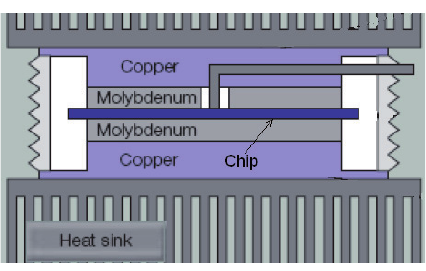
Fig. 5. Pressure Pack assembling stack.